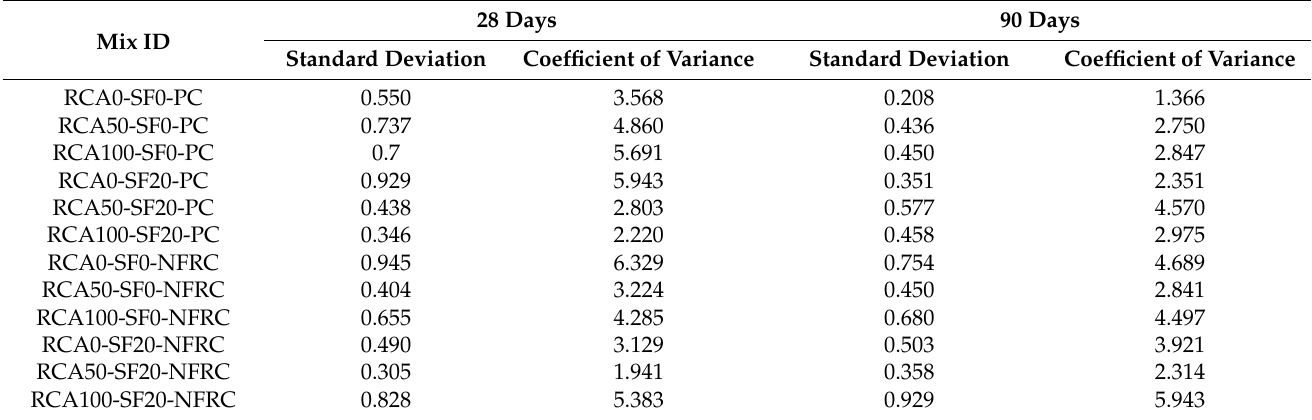
Table 7. Standard Deviation and Coefficient of Variation of Split Tensile Strength